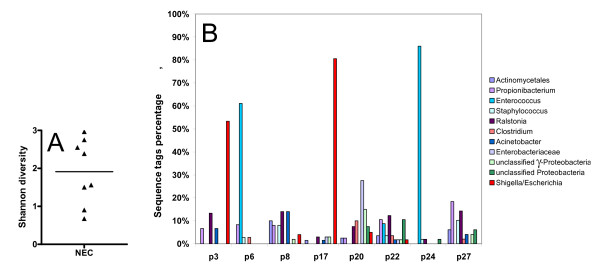
Overview and diversity of the bacterial composition by clone library analysis. a) Shannon's diversity index on phylum level divided the NEC infants in two groups. This difference could not be explained by antibiotic treatments or the severity of the necrotizing enterocolitis b) The bacterial 16S rRNA gene composition from each of the eight necrotic intestinal tissue samples. Bacterial groups whose abundance were more than 10% in any sample are shown as bars. Enterococcus and Escherichia spp. were the most abundant in the samples with a low Shannon diversity index where Ralstonia sp. was the most frequent group of species in the samples with a high Shannon index.